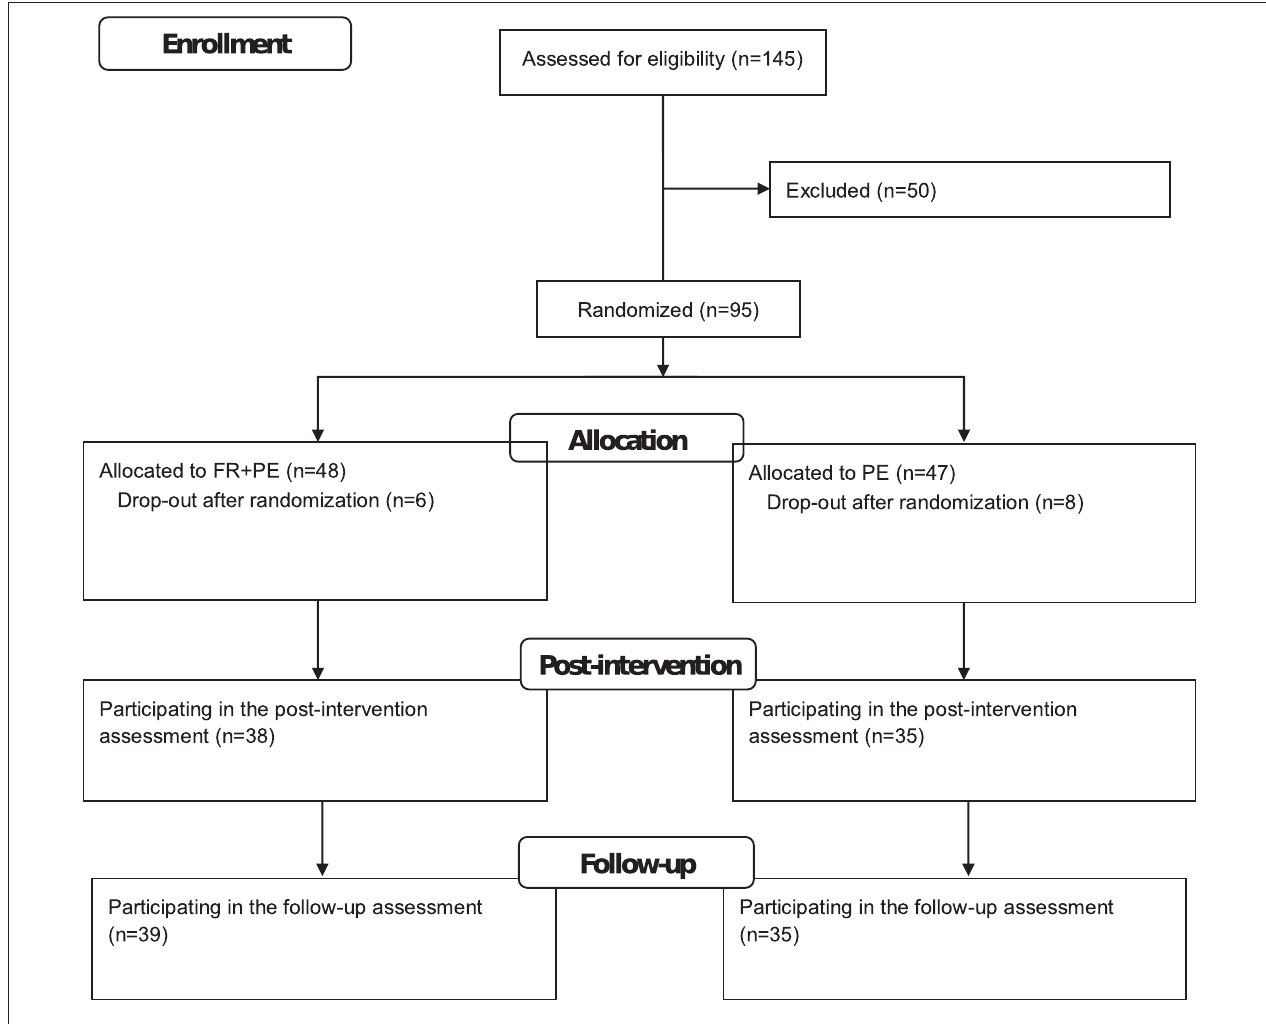
FIGURE 1 | Flow diagram of the